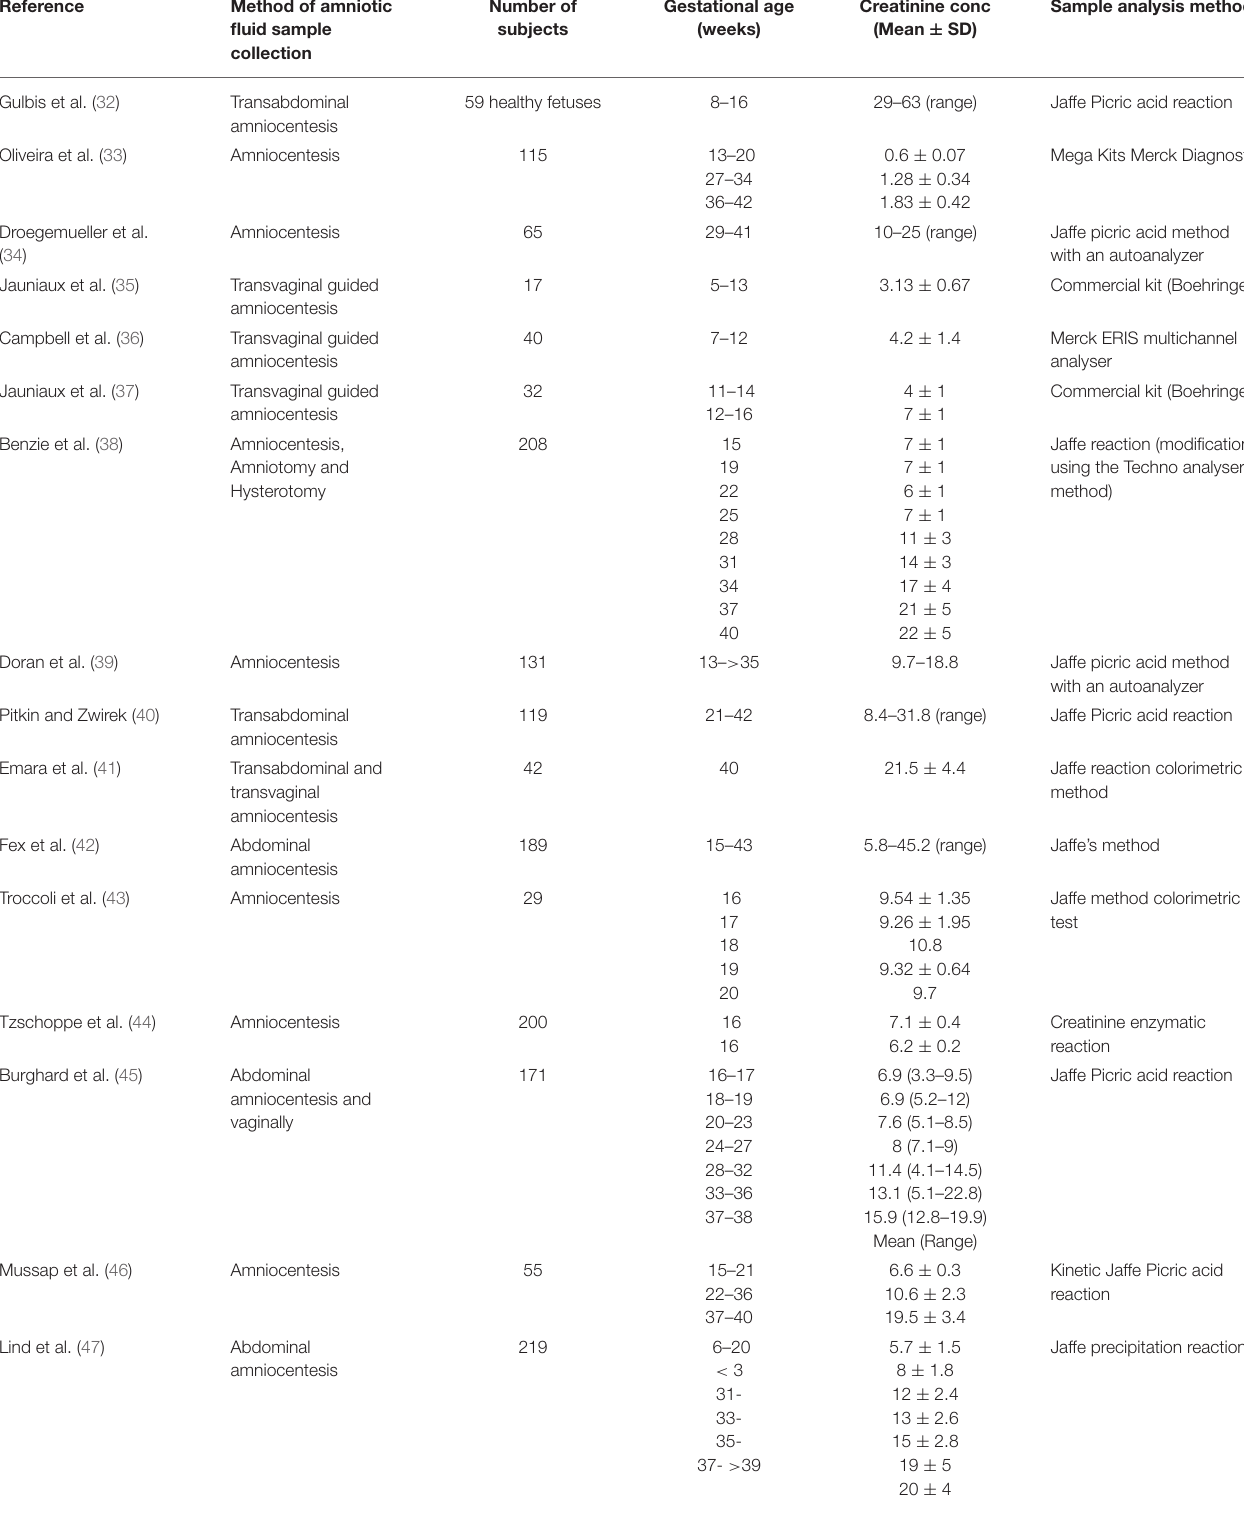
TABLE 2 | Summary of studies with measured values of amniotic fluid creatinine concentration (mg/L) at different gestational